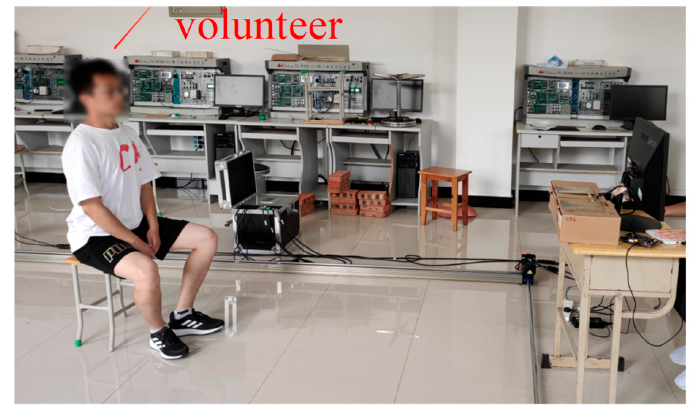
Figure 13. Experimental scene.